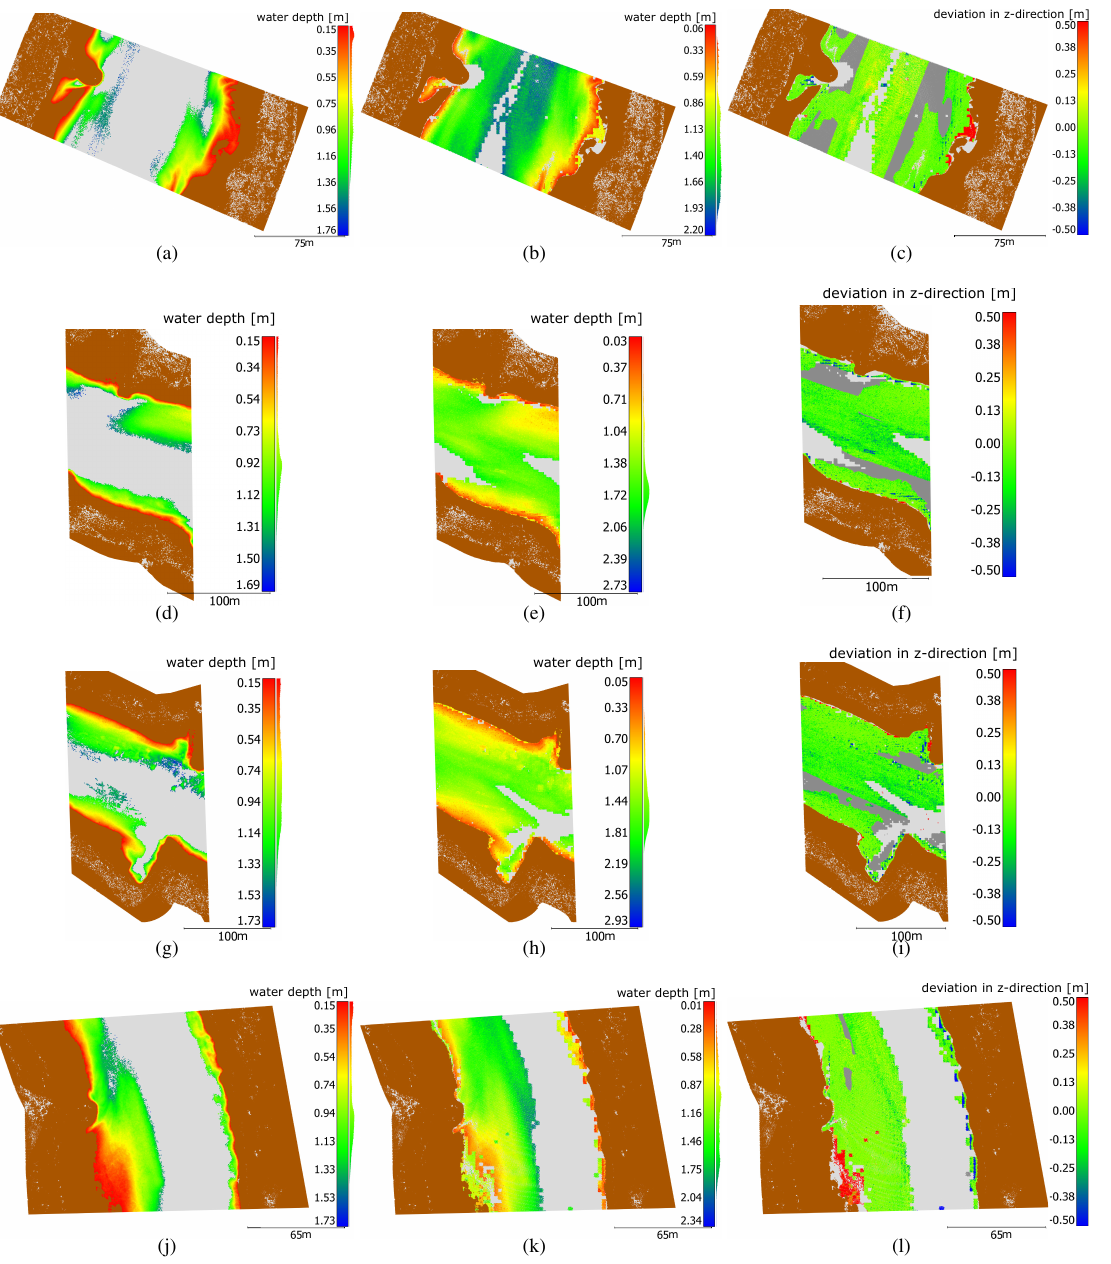
Figure 11. Evaluation of the results of Elbe 1 (a)-(c), Elbe 2 (d)-(f), Elbe 3 (g)-(i) and Elbe 4 (j)-(l). The left column shows the standard processed points with their water depth (color-coded) , the middle shows the new processed bottom points with their water depth (color-coded) and the right column shows the results of the comparison of both data related to the z-direction, where the dark-grey areas are incomparable new processed points (no comparative data available). Brown points are land